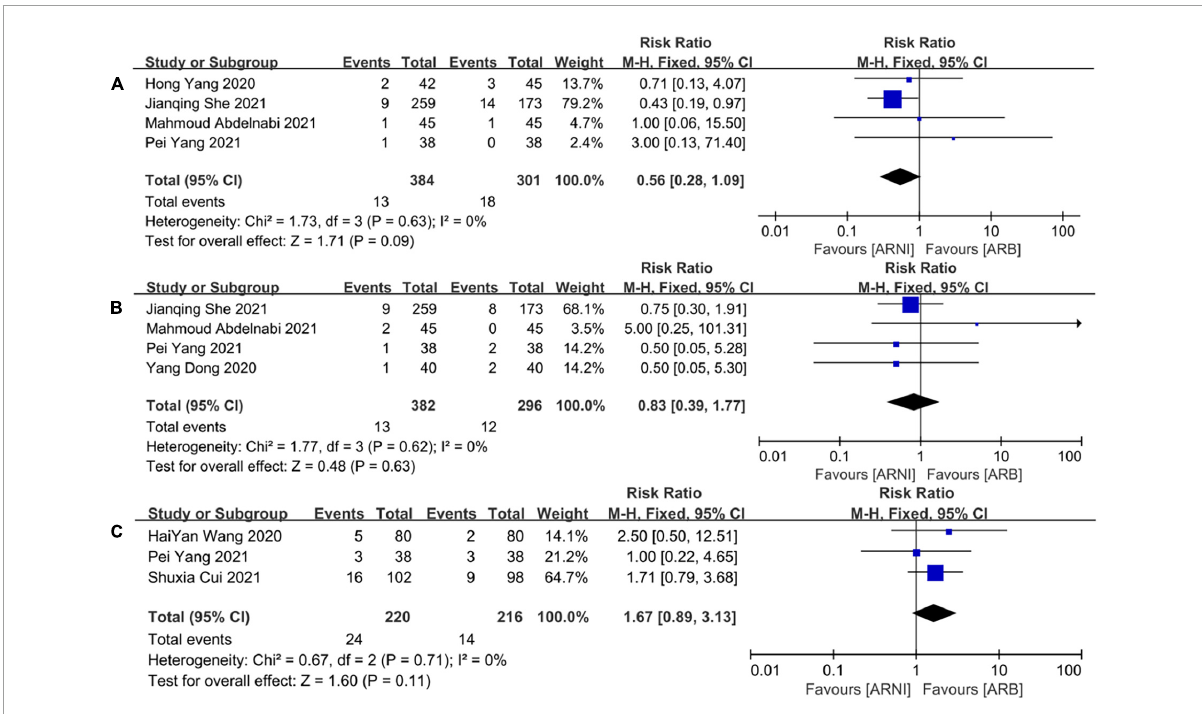
FIGURE12 The forest plots of the effectiveness and safety outcomes between early initiation of sacubitril/valsartan and angiotensin receptor blocker in patients after acute myocardial infarction (2). (A) The forest plots of the incidence of cardiac death, (B) the forest plots of the incidence of myocardial infarction, and (C) the forest plots of the adverse side